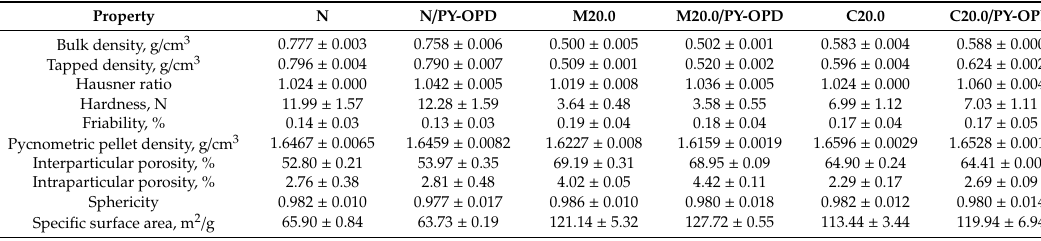
Table 1. Physical properties of pellets before and after impregnation with PY-OPD.